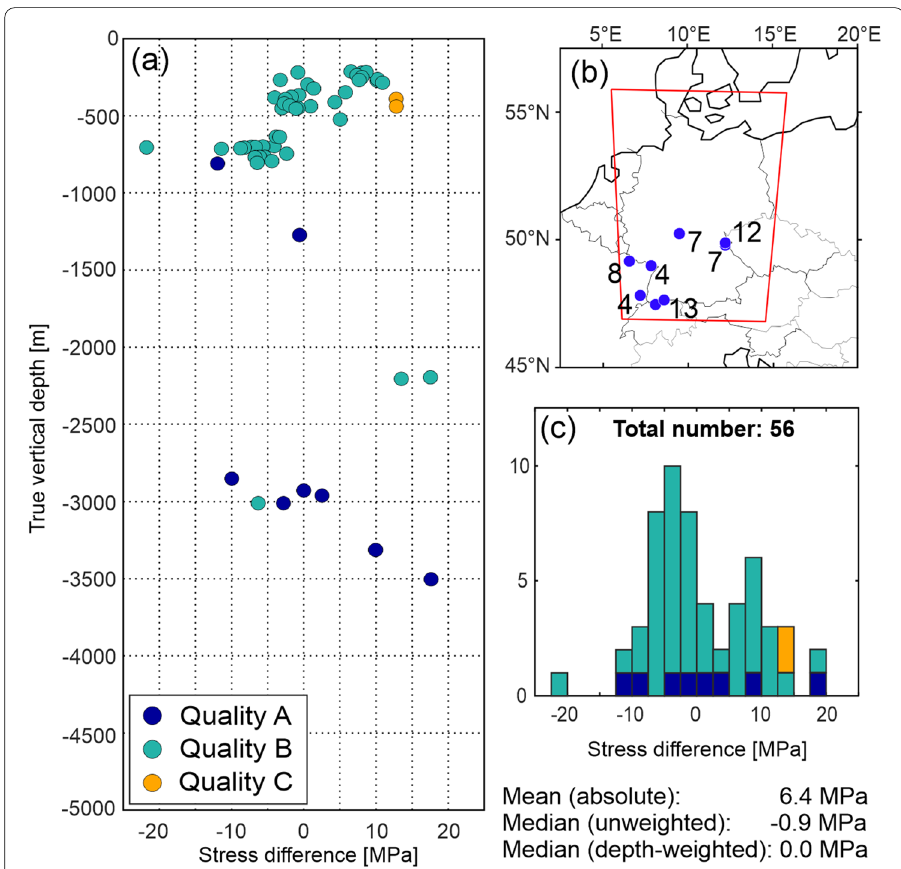
Fig. 8 S Hmax magnitudes of the model in comparison to data of Morawietz and Reiter (2020) used for calibration. a Color‑coded differences versus depth. Differences are calculated as model results minus calibration data. b Spatial distribution of stress magnitude data, used for calibration. Numbers indicate localities with multiple data records. c Color‑coded histogram of the differences displayed in